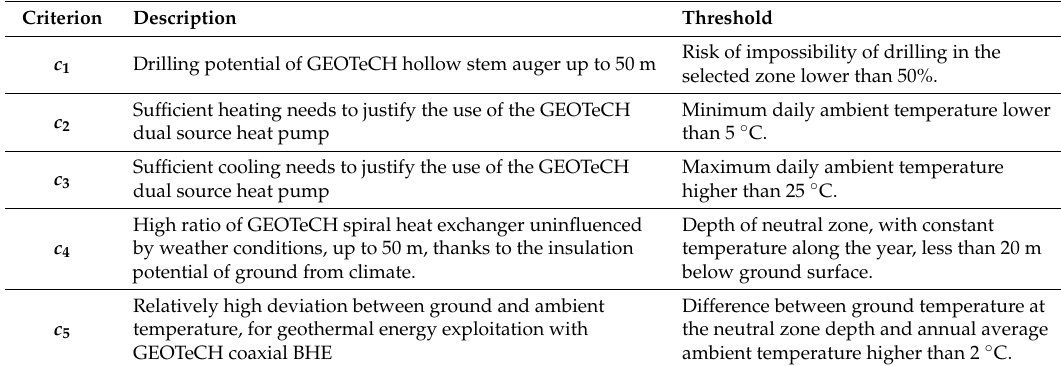
Table 4. Details of chosen criteria c , with description and thresholds assigned.